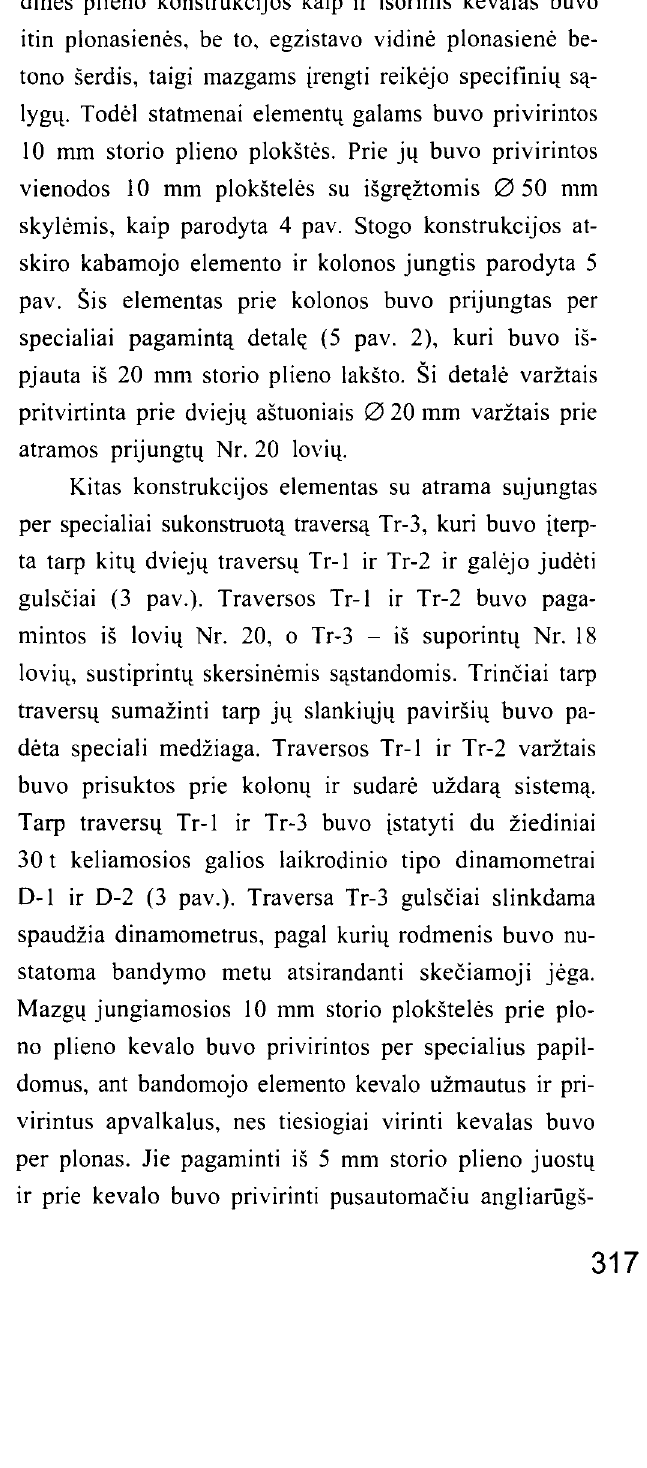
Fig 4. Middle node of the joint of members (bolt isn't shown)